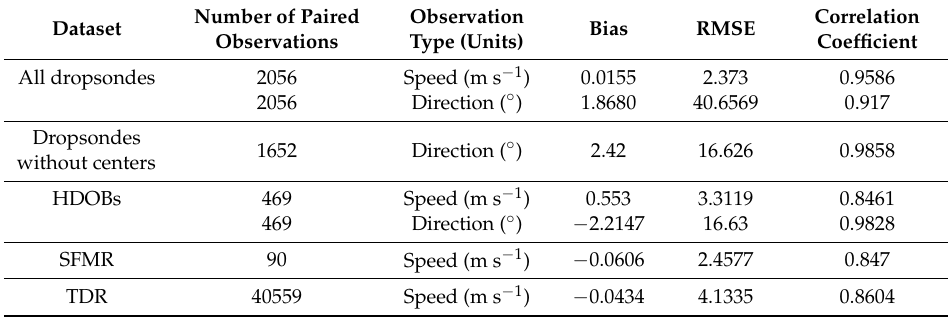
Table 3. Summary of the 2016 Airborne Doppler Wind Lidar validation